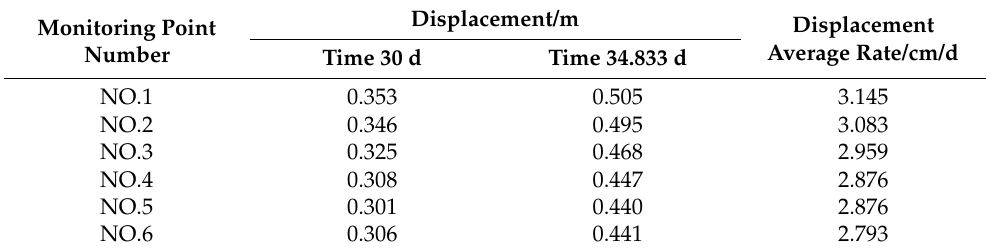
Table 3. Displacement and velocity of monitoring points around the tunnel.